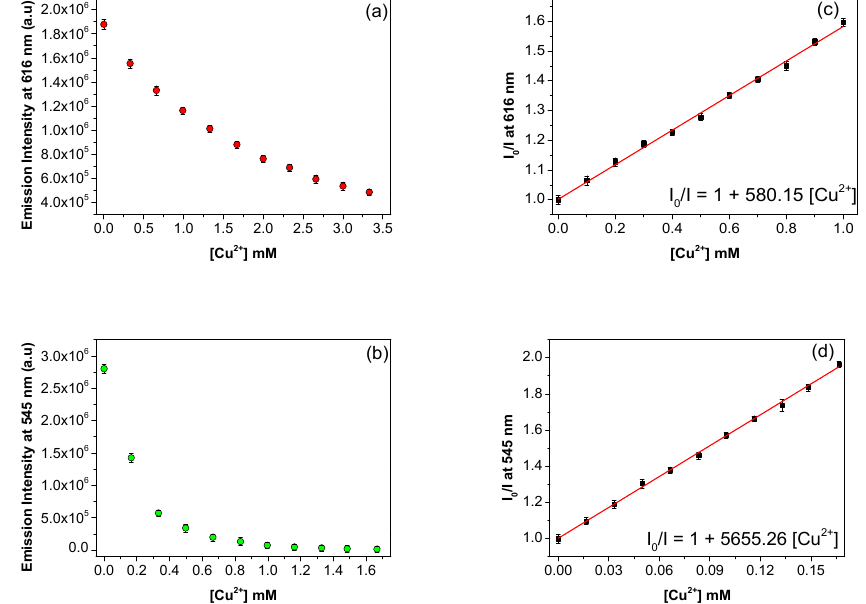
Figure 7. Emission intensities of ( a ) Eu 3+ /PSA ( 5 D 0 → 7 F 2 ) transition, ( b ) Tb 3+ /PSA ( 5 D 4 → 7 F 5 ) transition and Stern-Volmer plots of ( c ) Eu 3+ /PSA and ( d ) Tb 3+ /PSA with lower concentrations of Cu 2+ .